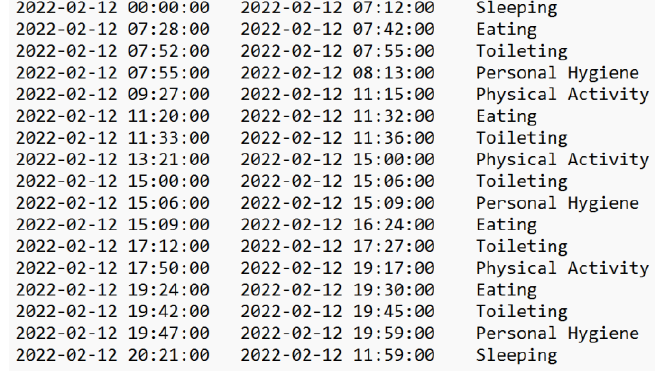
Figure 7. Daily activities detected for a person in a day (24 h).